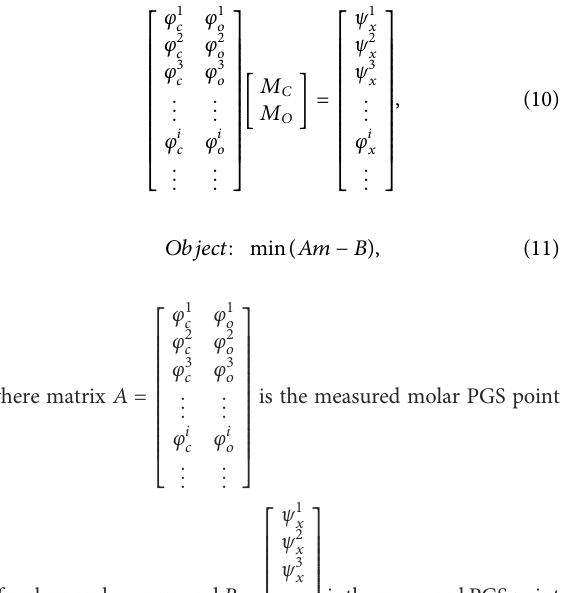
algorithm on three molecules: PMMA ( C 5 H 8 O 2 ),